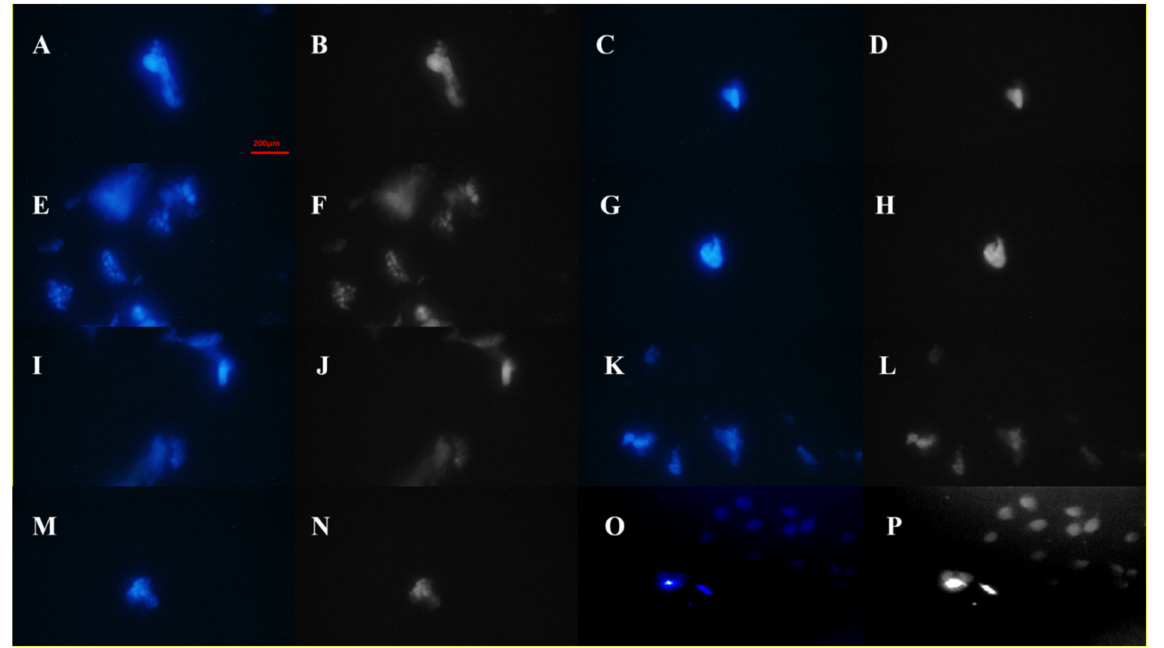
Figure 7. CLSM images of the MCF-7 cell line treated with NH 2 -MIL-53@H 2 TMP ( A – N ) after 48 h of treatment and the control group ( O , P ). The gray-scale images of the treated DAPI-stained MCF-7 cell lines ( B , D , F , H , J , L , N , P ) in order to show the exact morphology of the